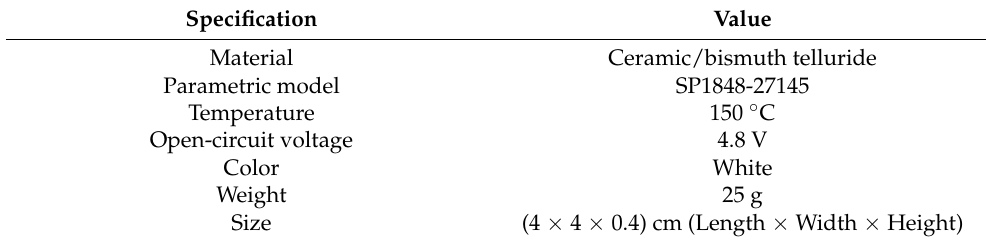
Table 1. Specifications of a single TEG